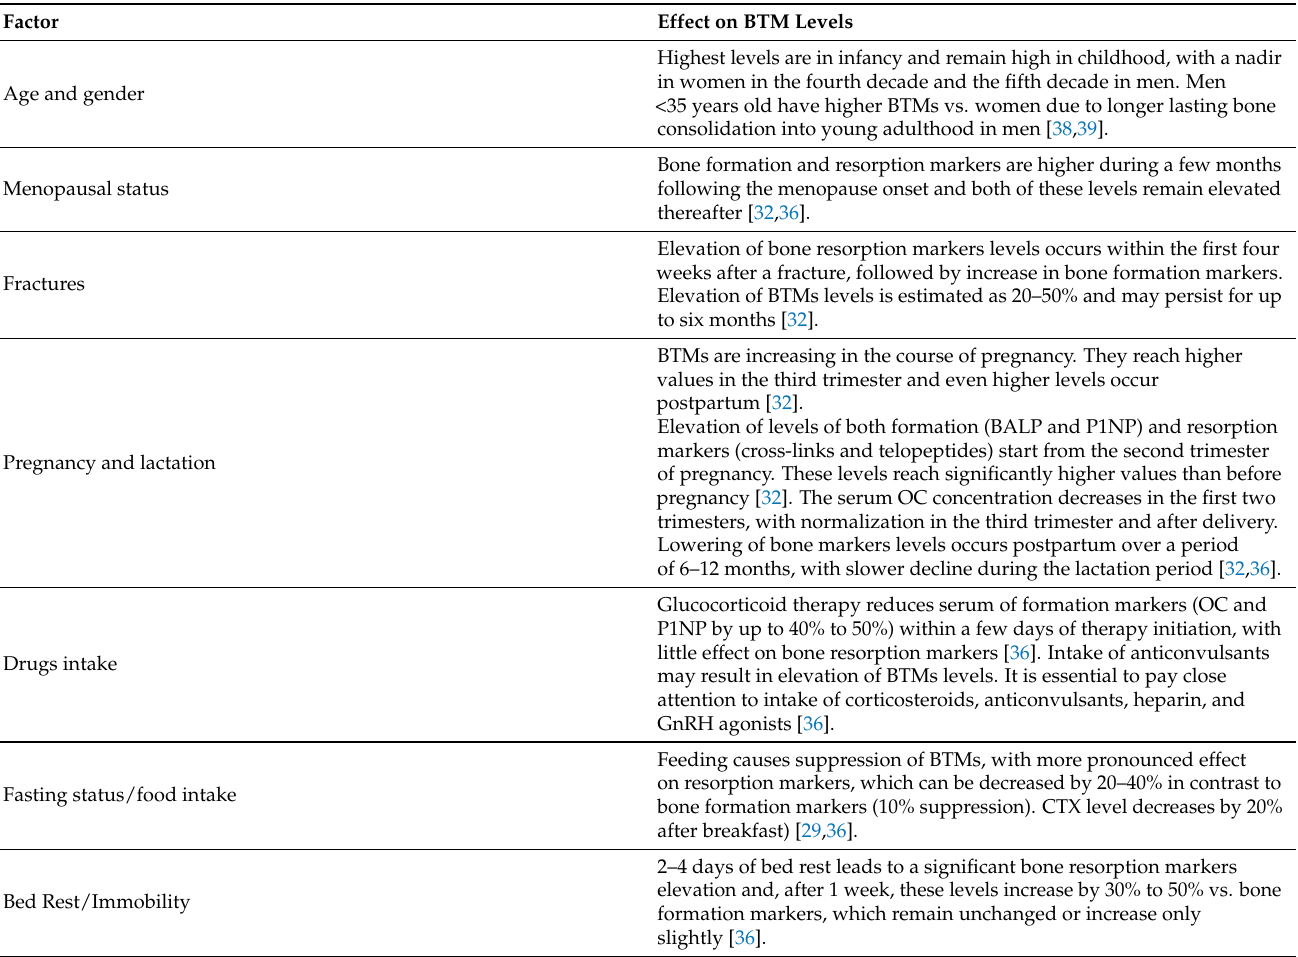
Table 2. Factors affecting bone turnover marker